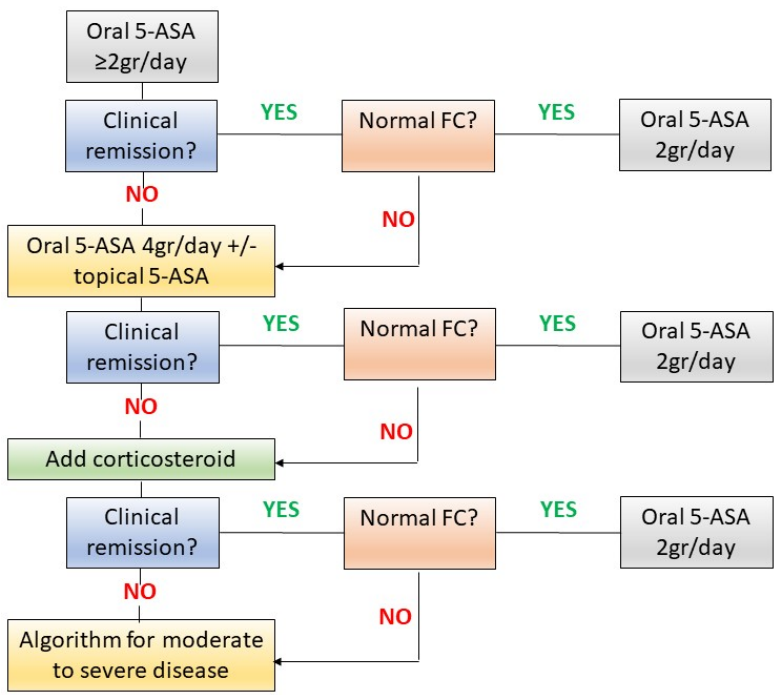
Figure 1. Proposed algorithm for the management of patients with mild ‐ to ‐ moderate ulcerative colitis. FC: fecal calprotectina. 5 ‐ ASA: mesalamine.